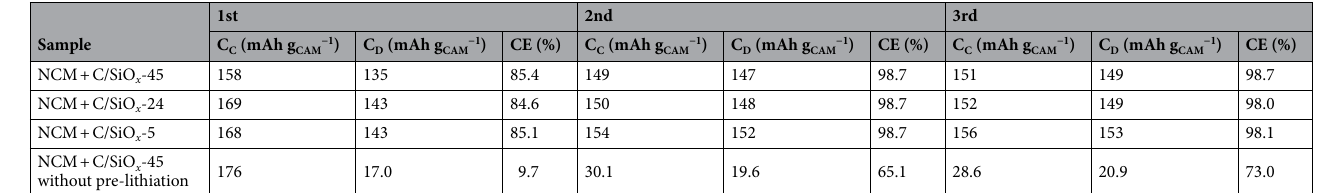
Table 2. Charge (C C ) and discharge (C D ) specific capacities and Coulombic efficiencies (CE) of the